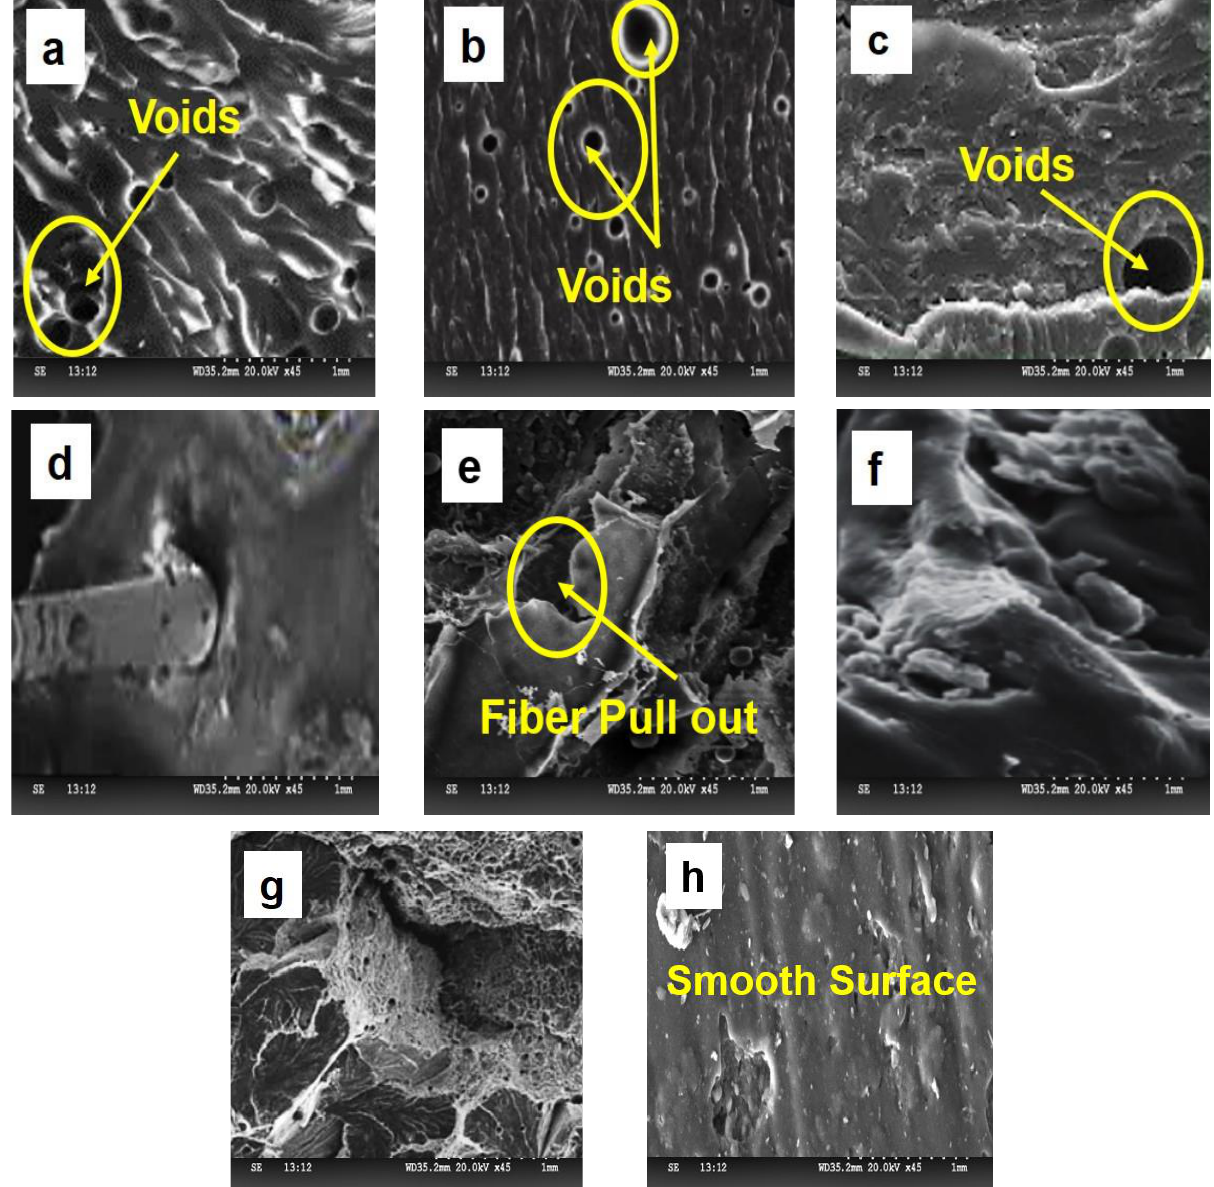
Figure 14. Microstructural Images of ( a ) Plain epoxy; ( b ) 0 wt.% of NaOH Treated; ( c ) 1 wt.% NaOH Treated; ( d ) 3 wt.% of NaOH Treated; ( e ) 5 wt.% of NaOH Treated composites; ( f ) 5 wt.% NaOH Treated Tensile failure; ( g ) 5 wt.% NaOH Treated Flexural failure; ( h ) 5 wt.% NaOH Treated Impact failure.